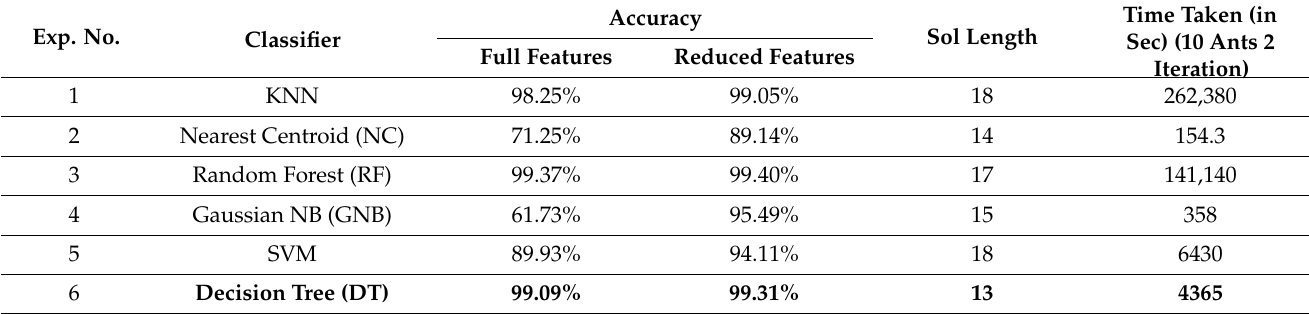
Table 11. Initial results to choose a suitable